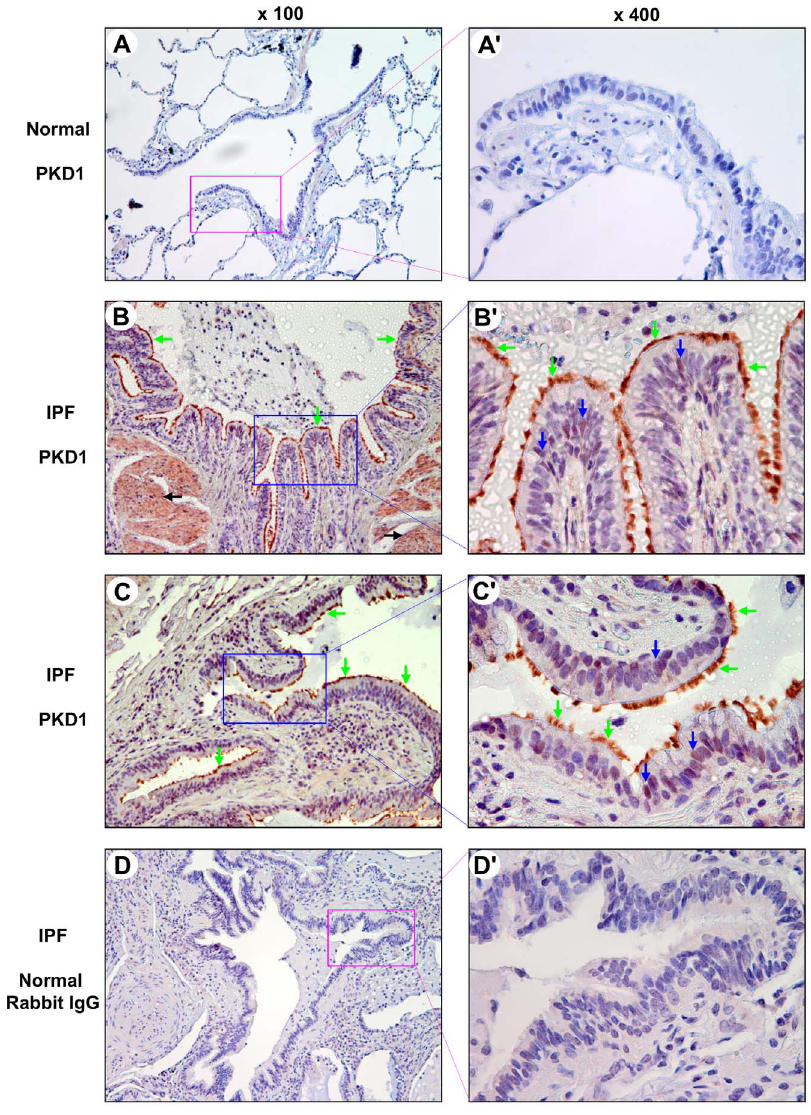
Figure 1. Expression of PKD1 in normal and IPF bronchiolar epithelia. Normal and IPF lung sections were subjected to immunohistochemical analysis by a PKD1 specific polyclonal antibody PKD1 (A-20) or a normal rabbit IgG at a dilution of 1:500. A and A 9 : normal lung bronchiolar epithelium was negative for PKD1. The region indicated in panel A (magnification, 6 100) is shown at higher magnification in A 9 ( 6 400). B–C 9 : in IPF lungs, PKD1 (red) was expressed abundantly in cilia (green arrows) and moderately in nuclei (blue arrows) of IPF BECs and in smooth muscle cells (B, black arrows). The regions indicated in panels B and C ( 6 100) are shown at higher magnification in B 9 and C 9 ( 6 400). D and D 9 : no specific signal was observed in IPF lung bronchiolar epithelium by a normal rabbit IgG. The region indicated in panel D ( 6 100) is shown at higher magnification in D 9 ( 6 400). membrane was probed with various primary antibodies as indicated and detected using the ECL system with horseradish peroxidase-conjugated secondary antibodies according to the manufacturer’s protocol (Cell Signaling).